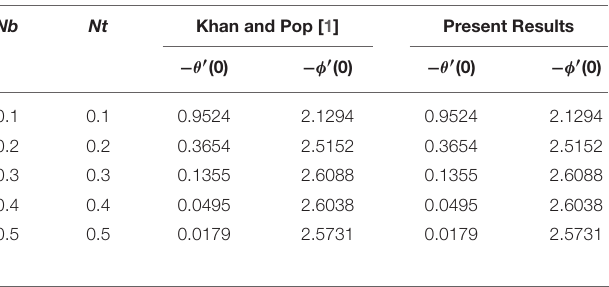
TABLE 2 | Values of the reduced Nusselt number − θ ′ (0), the Sherwood number − φ ′ (0) and the Skin-friction coefficient C fx